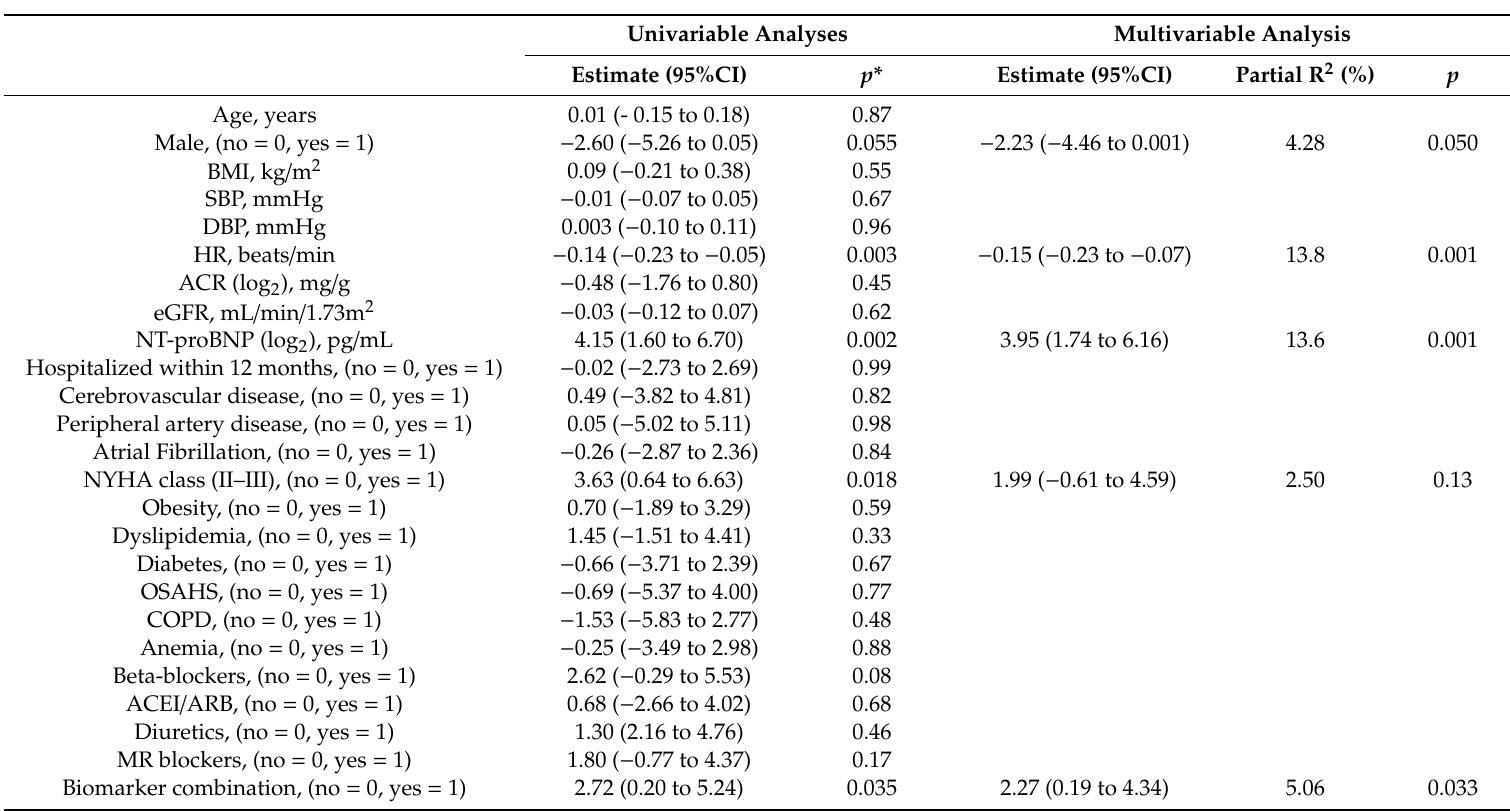
Table 5. Linear regression analyses for the E:e’ ratio in CKD patients with HFpEF.